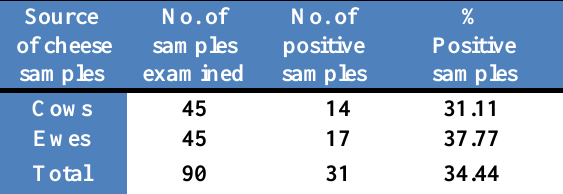
Table, 1: The prevalence of E. coli O157:H7 in bovine and ovine soft cheese samples that were collected from AL-Rasaffa districts.